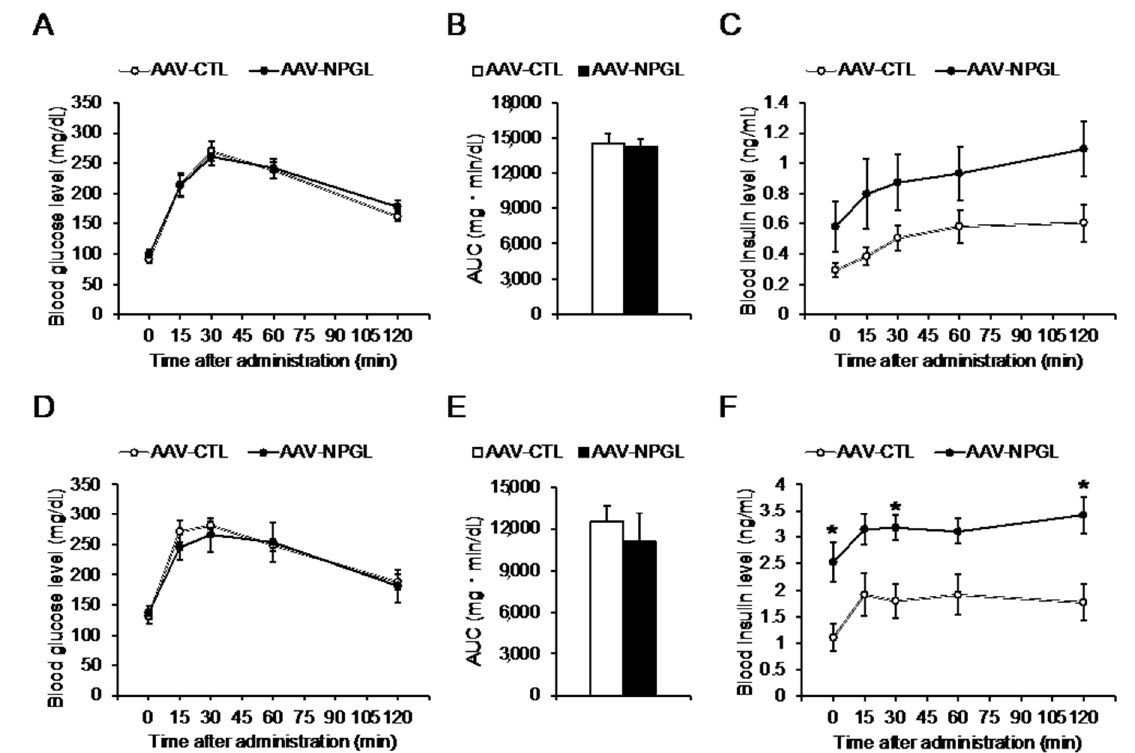
Figure 2. Effects of Npgl overexpression on glucose tolerance in mice fed a high-fat diet with 60% calories from fat (HFD 60). These mice were injected with an adeno-associated virus (AAV) vector, either a control (AAV-CTL) or a vector carrying the NPGL precursor gene (AAV-NPGL). ( A – F ) Results of the oral glucose tolerance test (OGTT) at multiple time points in HFD 60-fed mice tested 4 weeks ( A – C ) and 16 weeks ( D – F ) after surgery. ( A , D ) Blood glucose levels. ( B , E ) Area under the curve (AUC) for blood glucose levels. ( C , F ) Corresponding blood insulin secretion curves. Statistical analyses were performed using two-way repeated measures ANOVA followed by Bonferroni’s test ( A , C , D , F ) or Student’s t -test ( B , E ). Each value represents the mean ± standard error of the mean (AAV-CTL: n = 8, AAV-NPGL: n = 8; * p < 0.05).